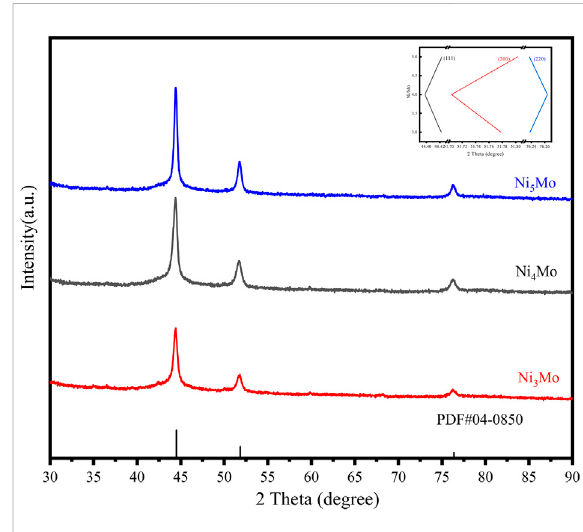
FIGURE 8 XRD patterns of samples with different ratios of Ni to Mo. The inset image shows the trend in the shift of the three main